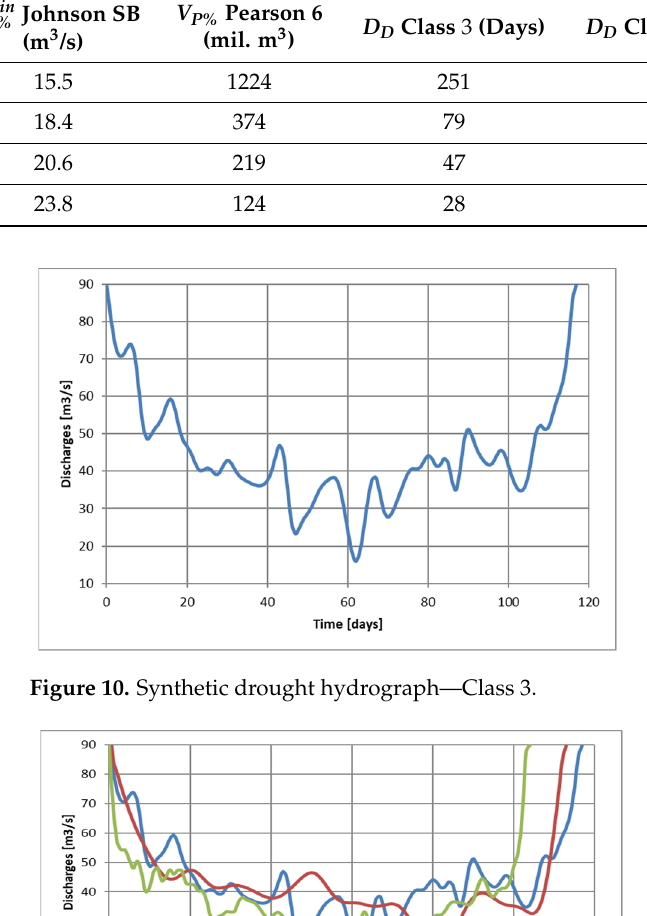
Figure 11. Synthetic drought hydrographs (cid:4666)𝑄 (cid:2877)(cid:2877)%(cid:3040)(cid:3036)(cid:3041) ; 𝑉 (cid:2869)% (cid:4667) for classes 3, 4 and 6. For the same class of droughts, not only the duration but also the minimum discharge and deficit volume are lower for higher probabilities of exceedance (cid:4666)𝑃 (cid:2869) %, 𝑃 (cid:2870) % (cid:4667) (Table 3 and Figure 12).